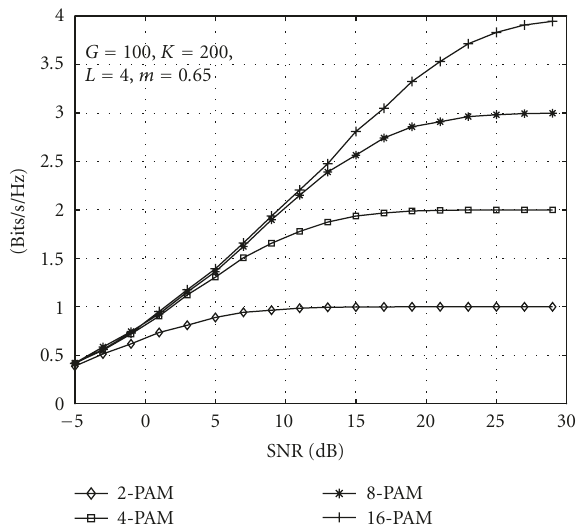
Figure 8: Capacity of a multiple access UWB system with PAM over a multipath fading channel with L = 4, m = 0 . 65, K = 200, G = 100, and P x = − 11 dBm.